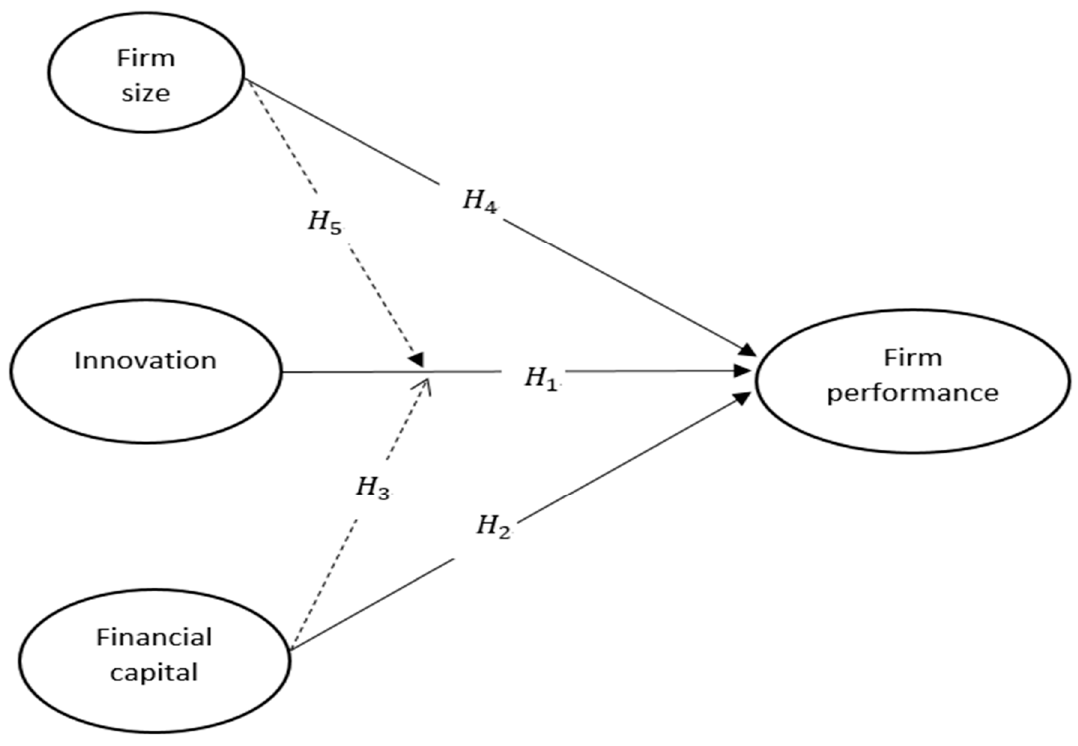
Figure 1. Research model and hypotheses.